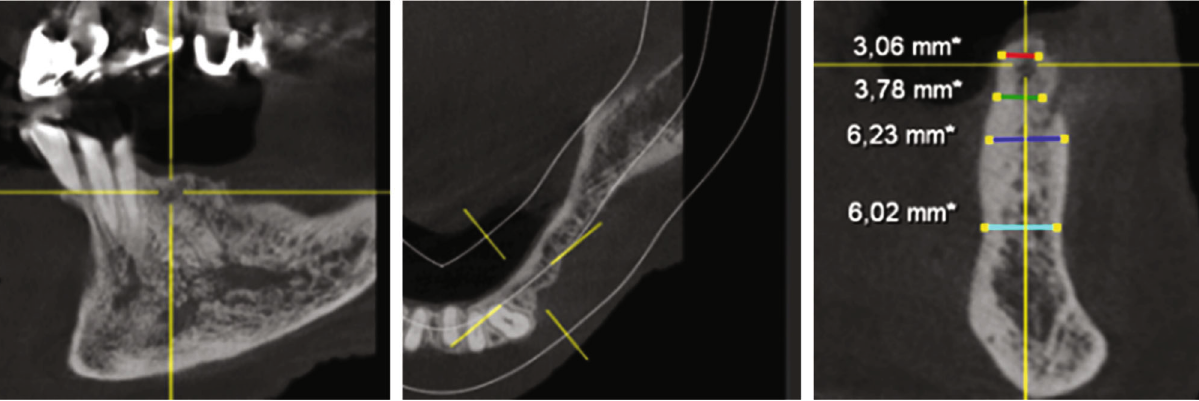
Figure 4: DVT — section region